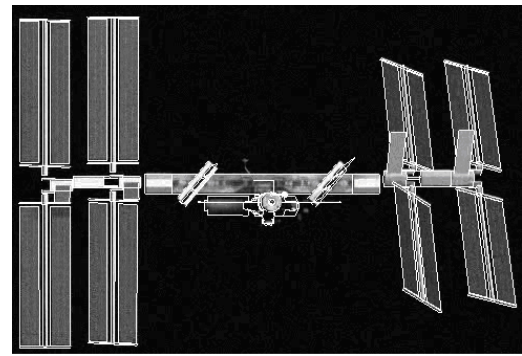
Figure 4. Model contour fitted to image using found pose parameters